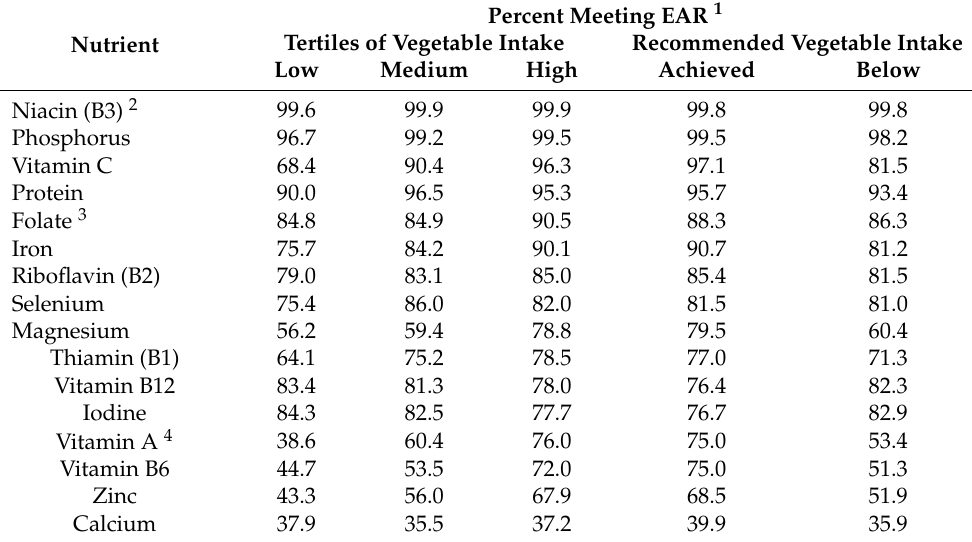
Table 5. The higher diet quality/lower environmental impact (HQLI) subgroup of adult (19 years old and above) daily diets in Australia: percent meeting nutrient estimated average requirements (EARs) for the low, medium, and high vegetable intake tertiles, for those diets achieving the Australian Dietary Guidelines’ recommended intake for vegetables, and those diets below recommended vegetable intake 1